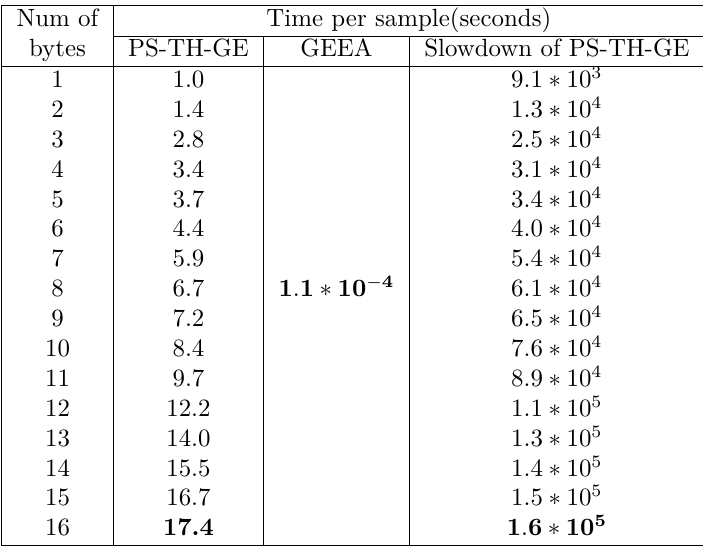
Table 1: Computational Comparison of PS-TH-GE and GEEA Num